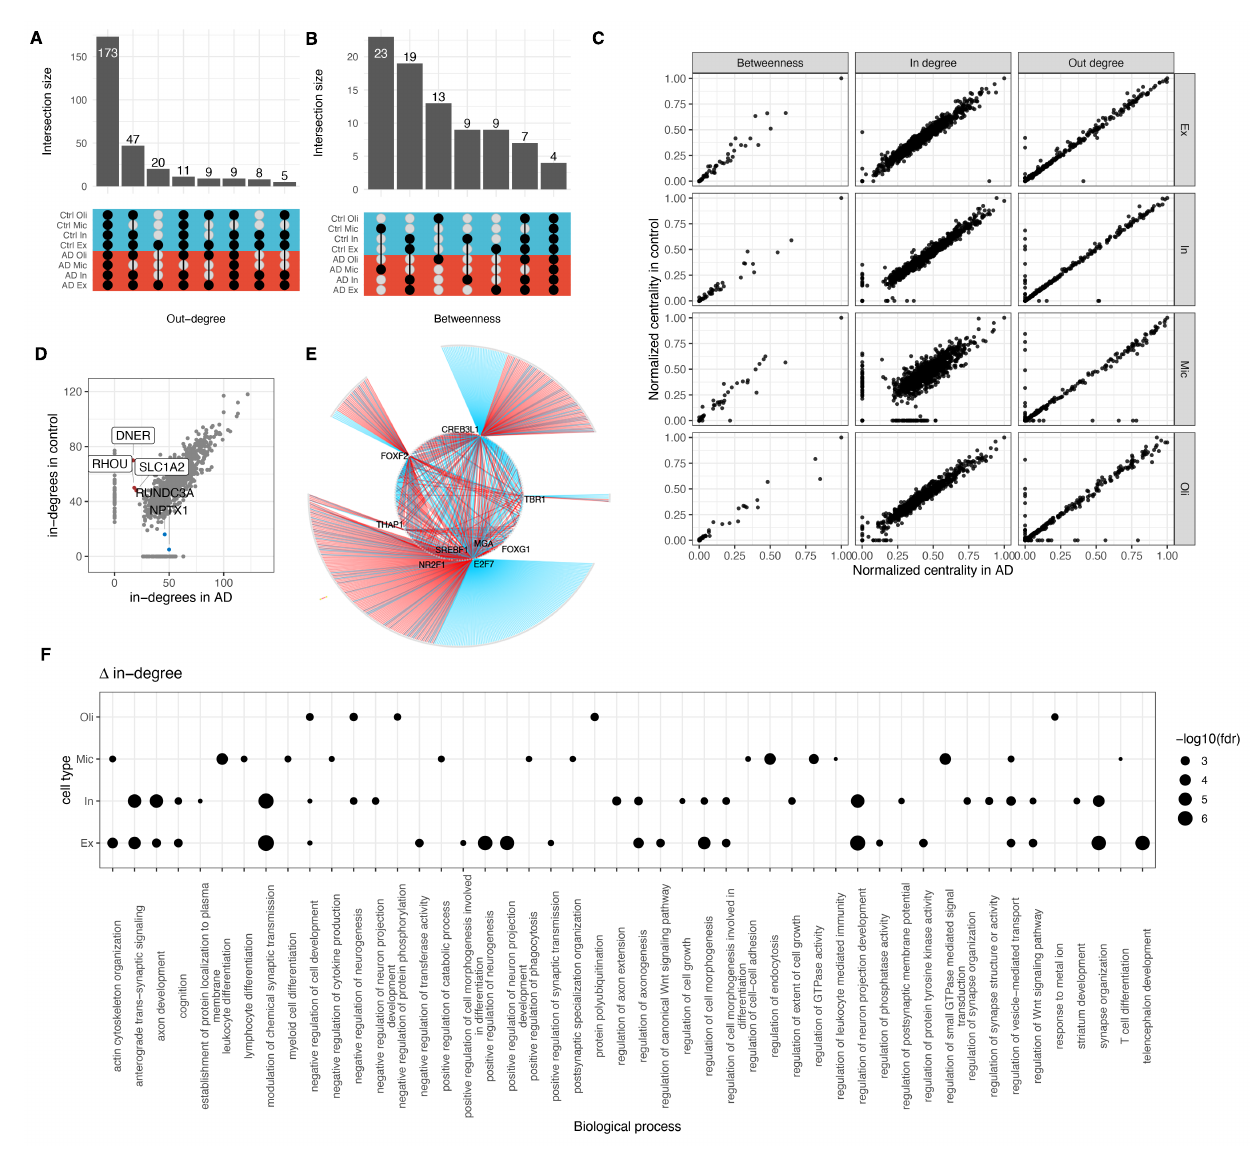
Fig 2. Centrality analysis reveal hub gene changes of cell-type gene regulatory networks in AD. ( A ) An upset plot showing overlaps between the top 10% genes with largest out-degree and ( B ) betweenness centralities. The filled dots in the center matrix indicate the comparison between the respective sets (along the x-axis), and the bars on the top show size of the intersection. Blue and red rows indicate control and AD, respectively. ( C ) Scatter plots showing normalized gene centralities distribution and ( D ) the distribution of in-degrees in microglial AD and control networks. Genes with large changes in in- degree between AD and control are labelled. ( E ) Visualization of the subnetwork of 9 TFs with high betweenness centrality in microglia. Grey circles around the periphery of the network indicate target genes. Symbols of the nine central TFs are shown and the rest hidden for clarity. Blue and red edges indicate interaction in the control and AD networks, respectively. ( F ) A dot plot showing enrichment of gene ontology biological processes (y-axis) among genes with the most extensive changes in the in-degree centrality across all cell types (x-axis). The dot size is set according to the FDR-corrected p values, as shown in the